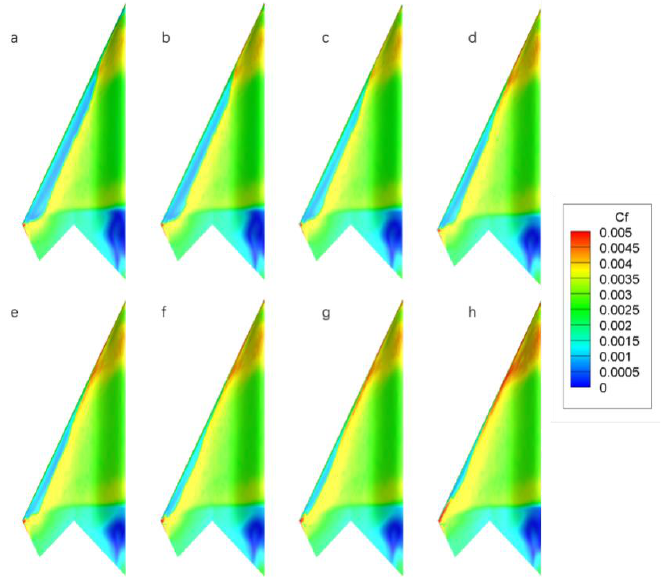
Figure 10. Friction coefficient distributions on the upper surface of the flying wing model with dif- ferent turbulence levels ( M = 0.9, α = 2°, Re = 10 × 10 6 ): ( a ) T u = 0.05%; ( b ) T u = 0.1%; ( c ) T u = 0.2%; ( d ) T u = 0.3%; ( e ) T u = 0.4%; ( f ) T u = 0. 5%; ( g ) T u = 0.6%; ( h ) T u = 0.7%.